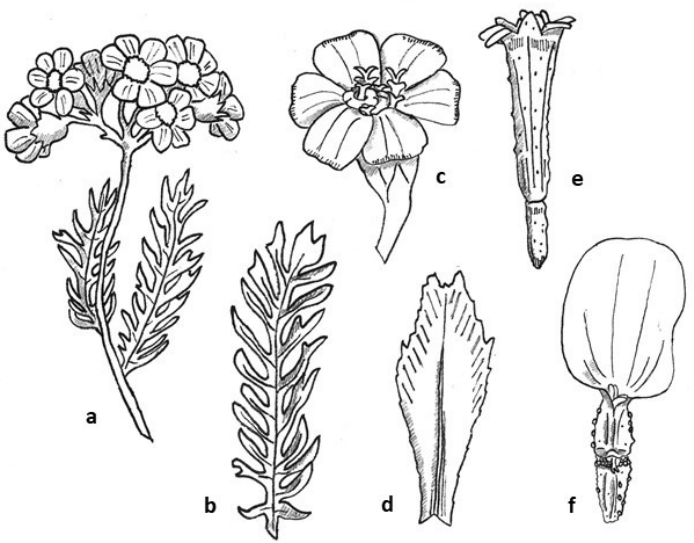
Figure 3. Botanical line drawings of Achillea moschata Wulfen: ( a ) Plant in toto . ( b ) Bipinnate leaf. ( c ) Flower head. ( d ) Involucral bract. ( e ) Disk floret. ( f ) Ray floret. Original drawings by L. Colombo.